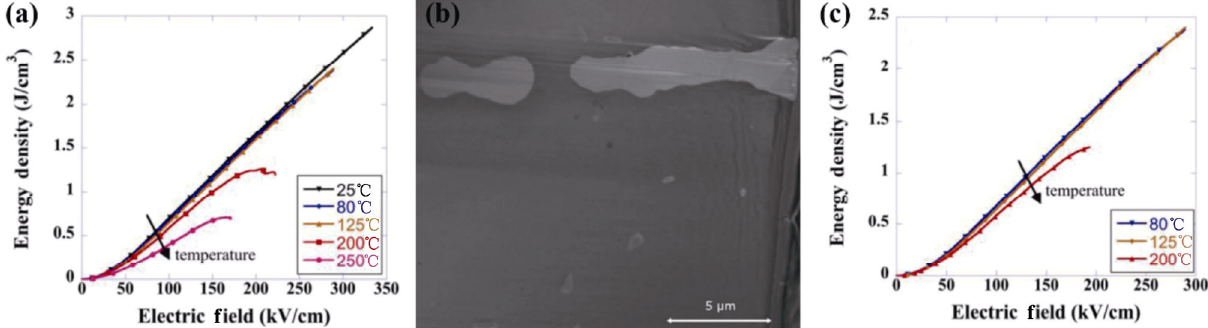
Fig. 27 Energy density of the BT–BZT MLCCs with (a) Pt alloy and (c) Ag/Pd alloy as the internal electrodes at various temperatures. (b) Cross-section SEM image of the MLCCs with Ag/Pd alloy as internal electrodes. Reproduced with permission from Ref. [129], © AIP Publishing LLC